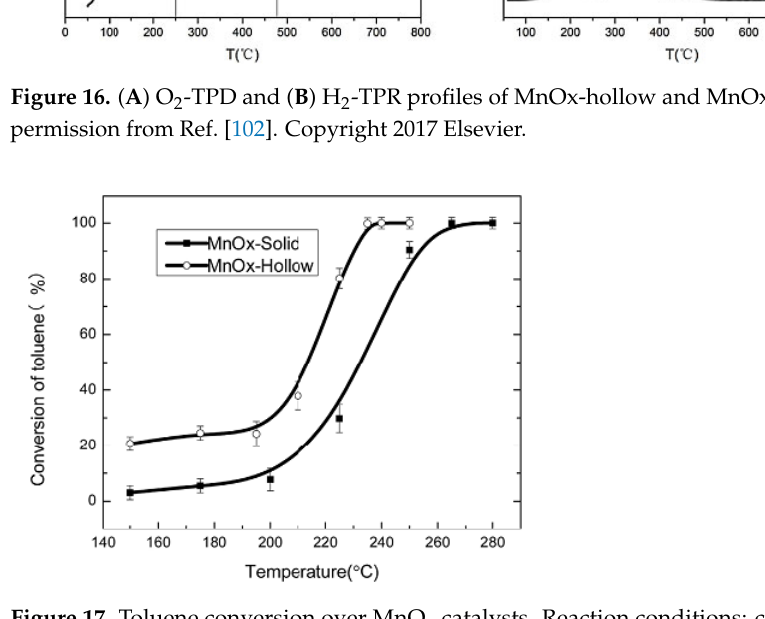
Ref. [102]. Copyright 2017 [102]. Copyright 2017 Elsevier.